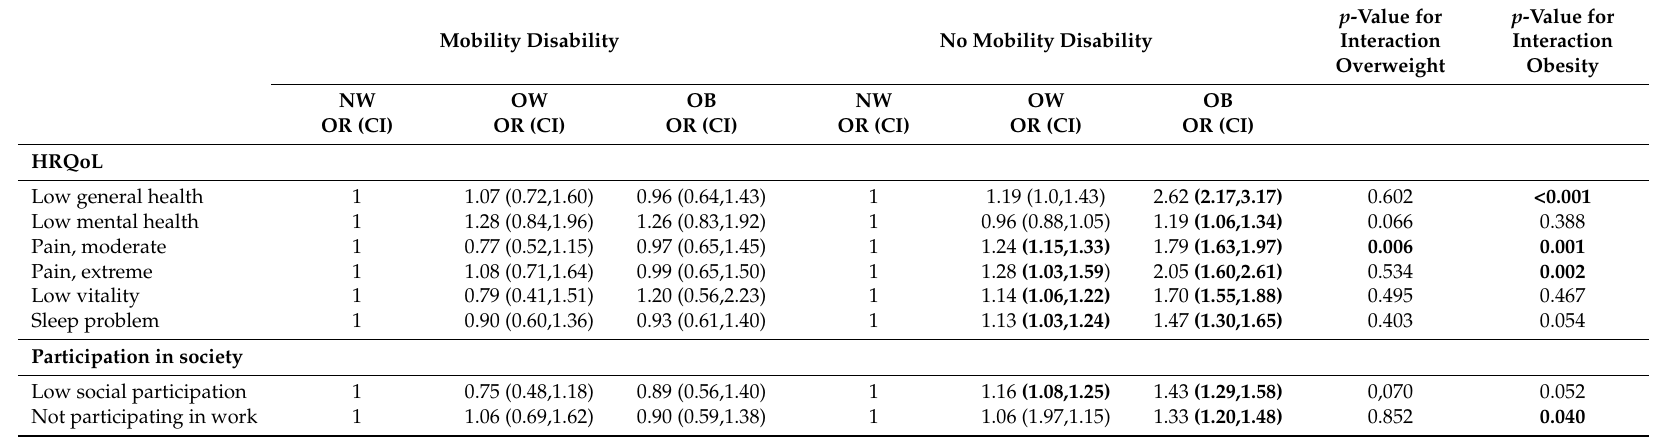
Table 2. Interaction effect between mobility disability and weight status and the association between mobility disability and health-related quality of life (HRQoL) and participations in society in different weight groups; n =